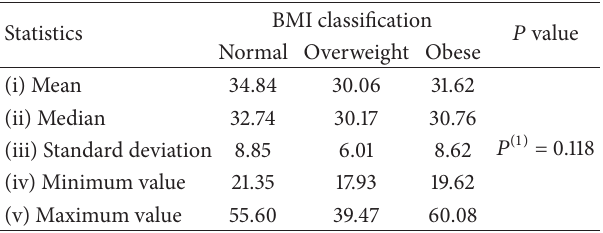
Table 3: Statistics on left atrium volume according to BMI classifi-